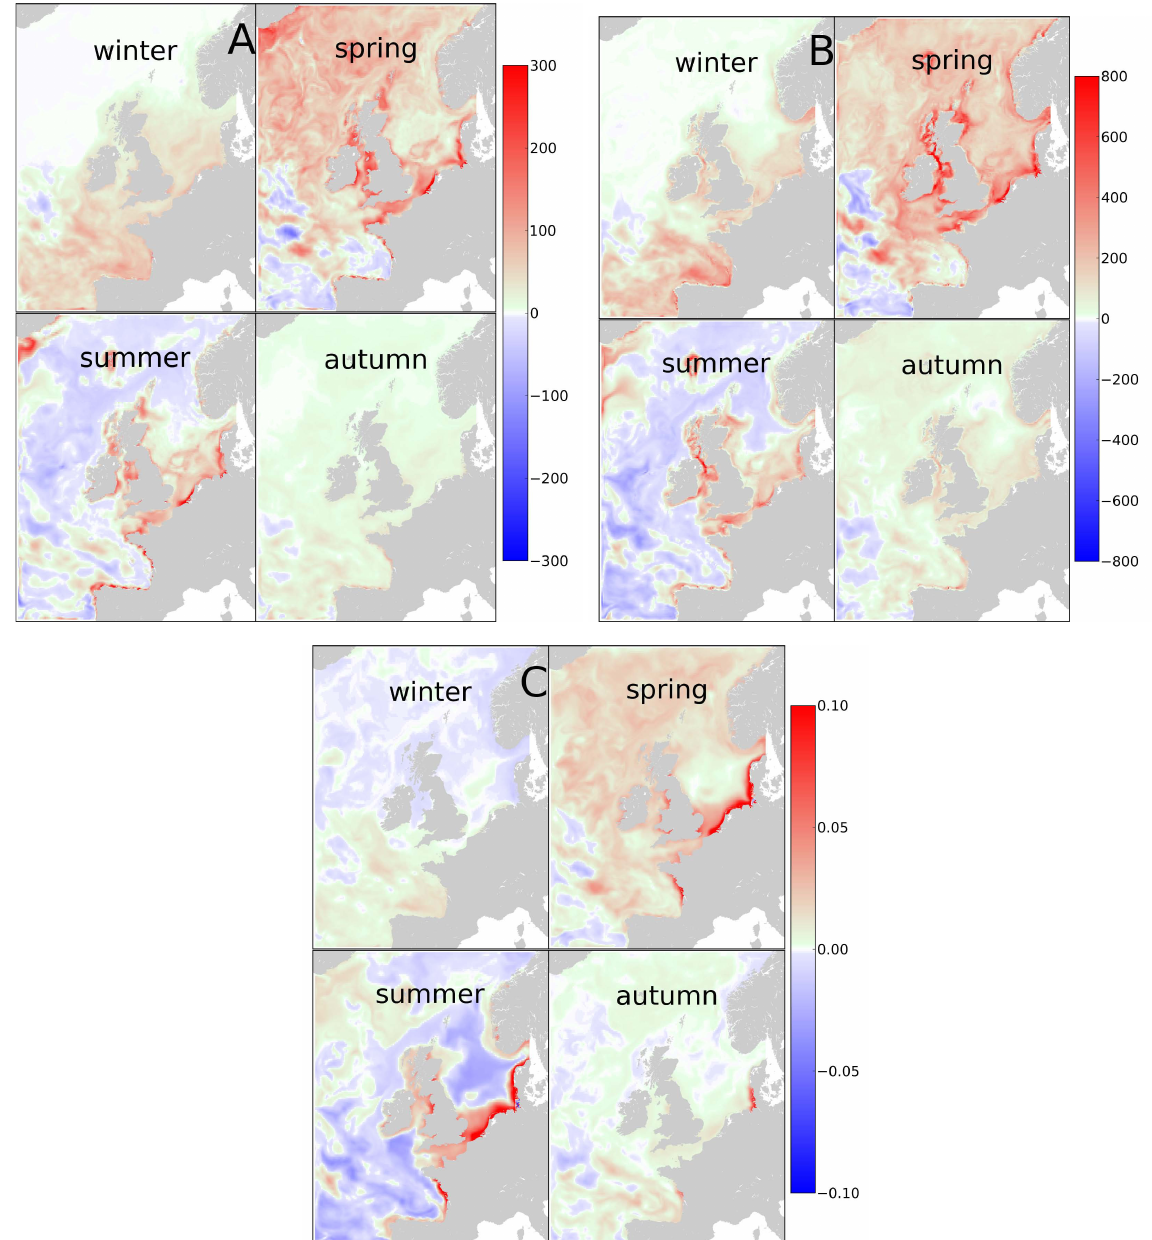
Fig. 6. Impacts of the enhanced primary production due to OA (A1B PP minus A1B scenarios). (a) absolute difference in net primary production (depth integrated, mgCm − 2 d − 1 ) , (b) difference in zooplankton biomass (depth integrated, mgCm − 2 ) , (c) difference in pH in the surface